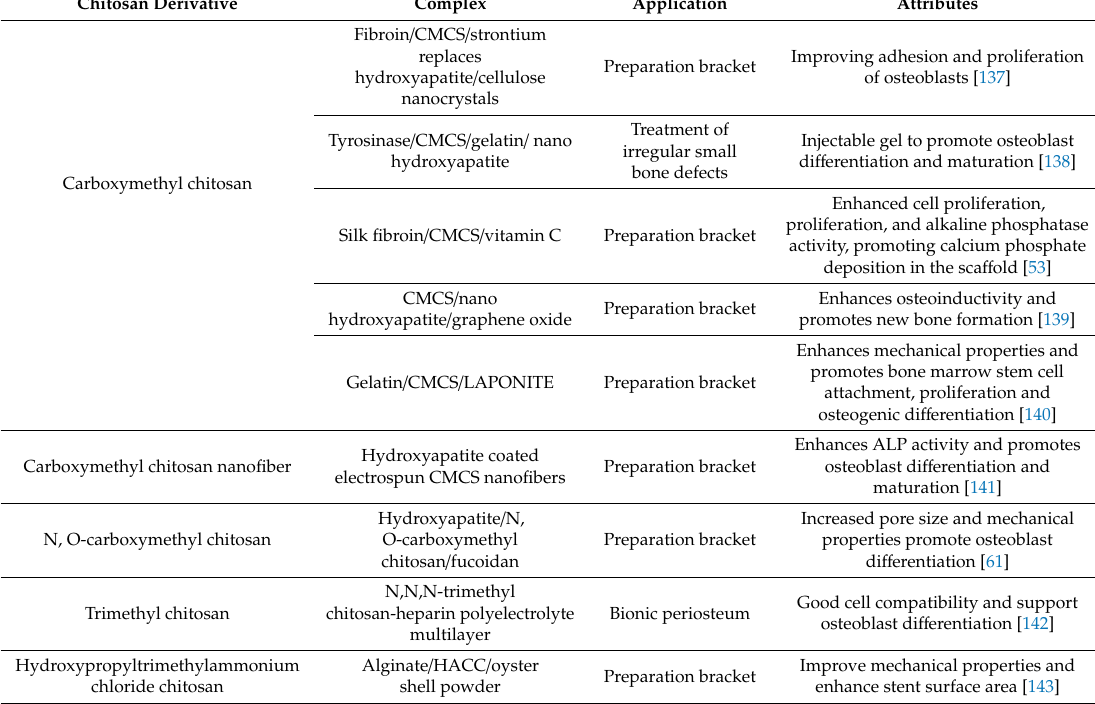
Table 2. Applications of common chitosan derivatives in bone tissue